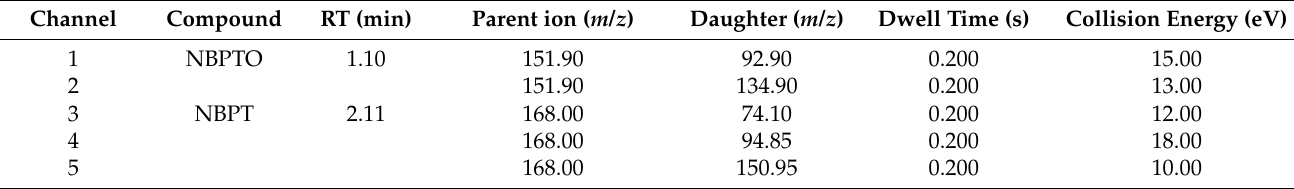
Table 3. Mass Spectrometer settings for MRM of 5 mass pair in ESI+